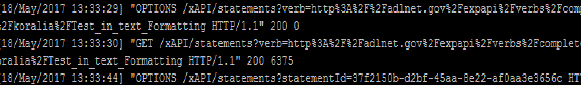
Figure 5. An example of the request of a statement towards the